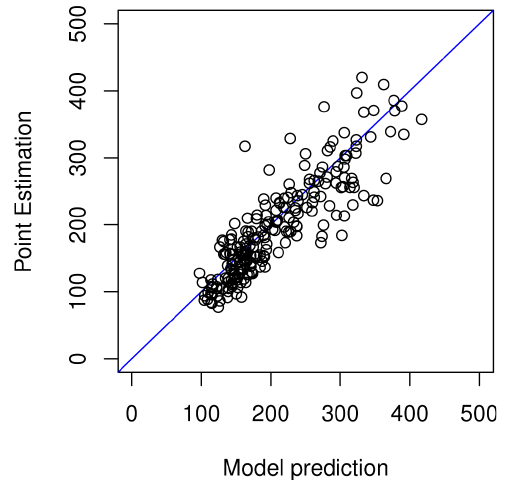
Fig. 4. Scatter plot of 100-yr return levels estimated locally versus the return levels predicted by RS3. Pearson’s correlation is